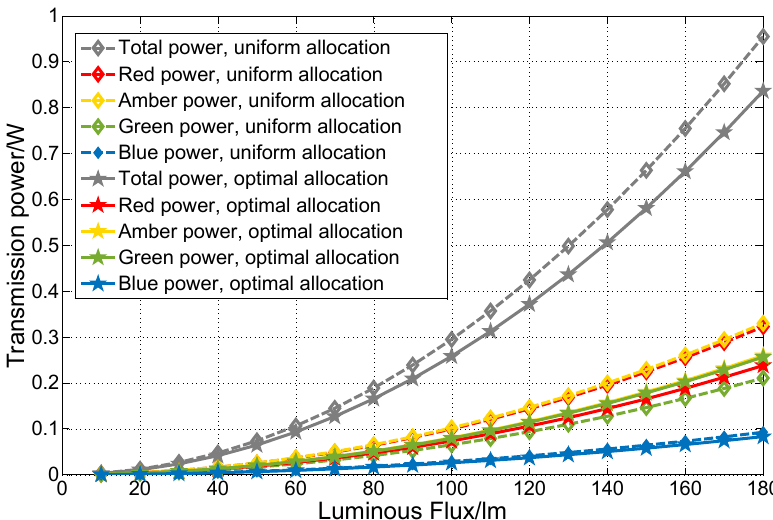
Figure 5. Transmission power comparison between the proposed optimal power allocation strategy and the uniform power allocation method with interference coefficient τ = 0.05 under CCT = 5700 K.